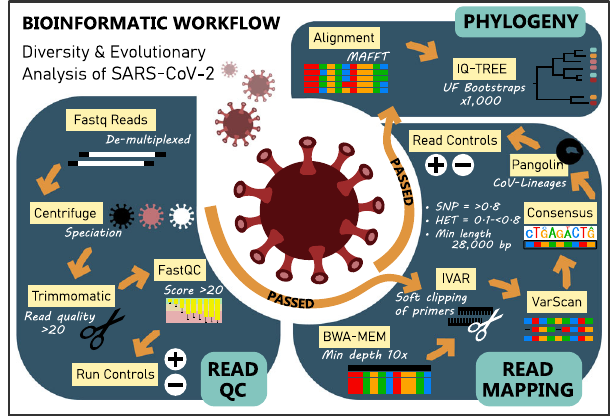
Fig. 1 Overview of SARS-CoV-2-speci fi c bioinformatic work fl ow. Created using Af fi nity